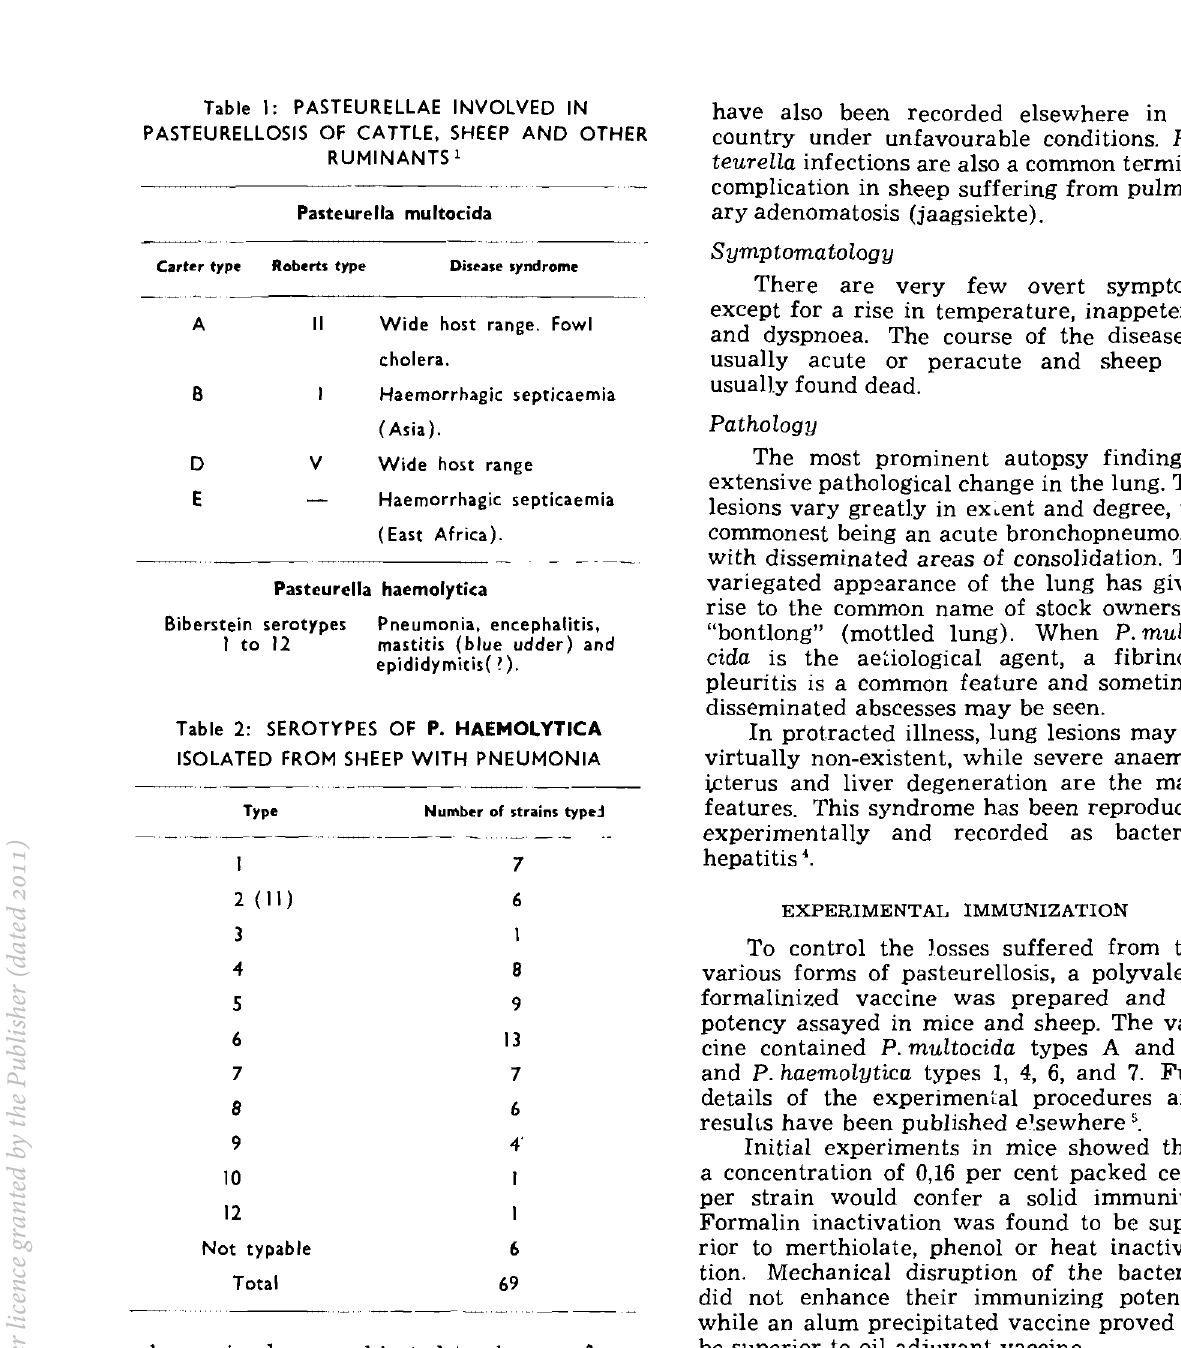
Table 1: PASTEURELLAE INVOLVED IN PASTEURELLOSIS OF CATTLE, SHEEP AND OTHER RUMINANTS 1 Pasteurella multocida